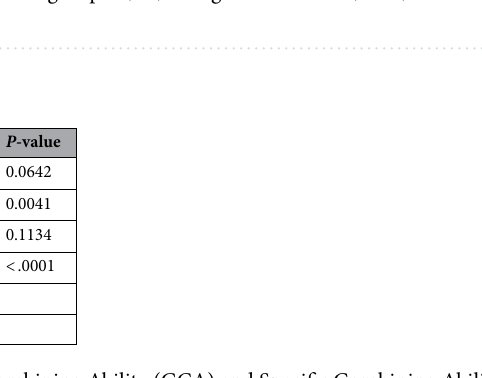
Table 4. Variance components of General Combining Ability (GCA) and Specific Combining Ability (SCA) from diallel analysis method-II for grain yield across three locations.